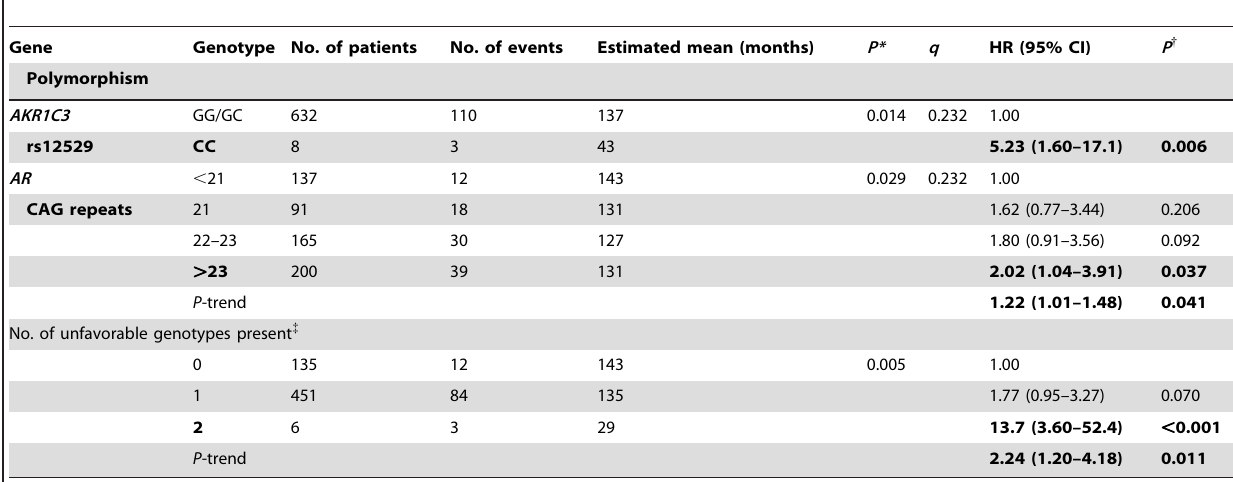
Table 3. Genotyping frequencies and the association of genotype with PCSM during ADT.